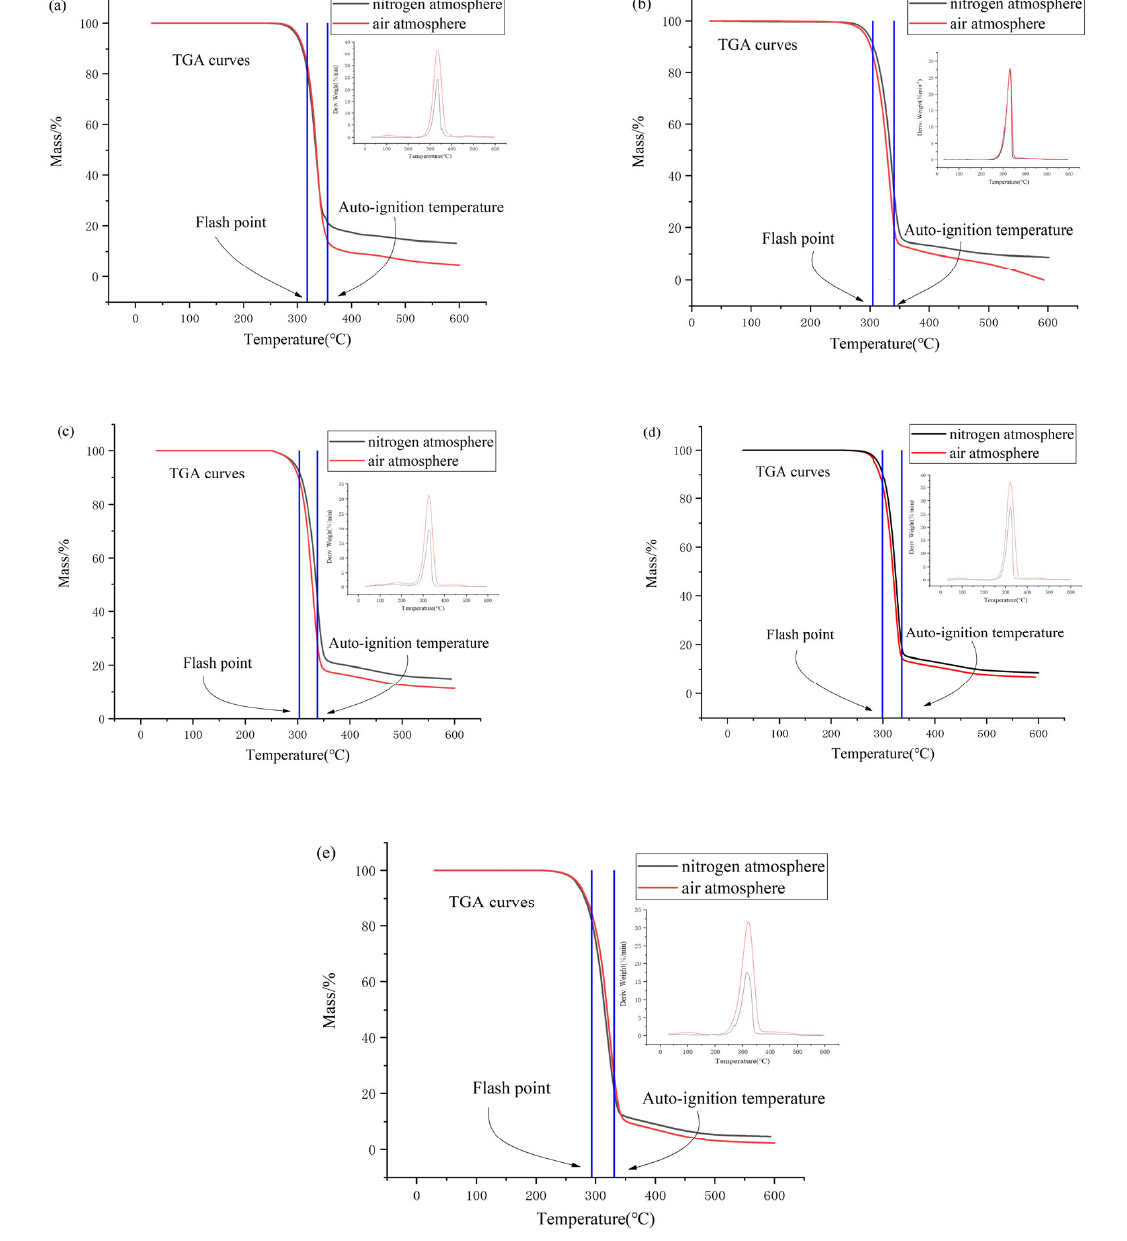
Figure 3. TGA–DTG curves of [Emmim][NO 3 ] ( a ), [Bmmim][NO 3 ] ( b ), [Hmmim][NO 3 ] ( c ), [Ommim][NO 3 ] ( d ) and [Dmmim][NO 3 ] ( e ).